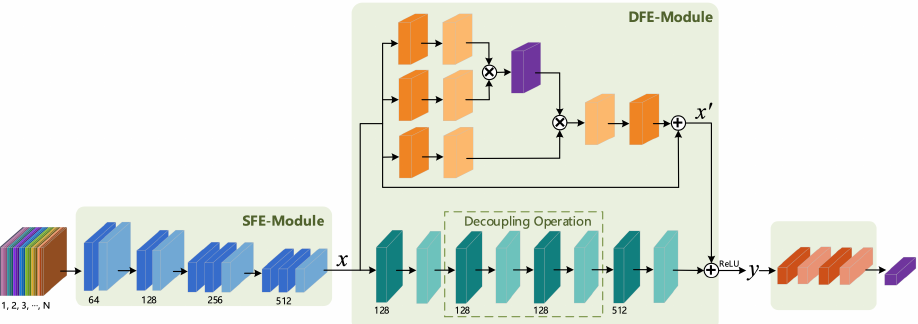
Figure 8. The architecture of AR3D_V1.